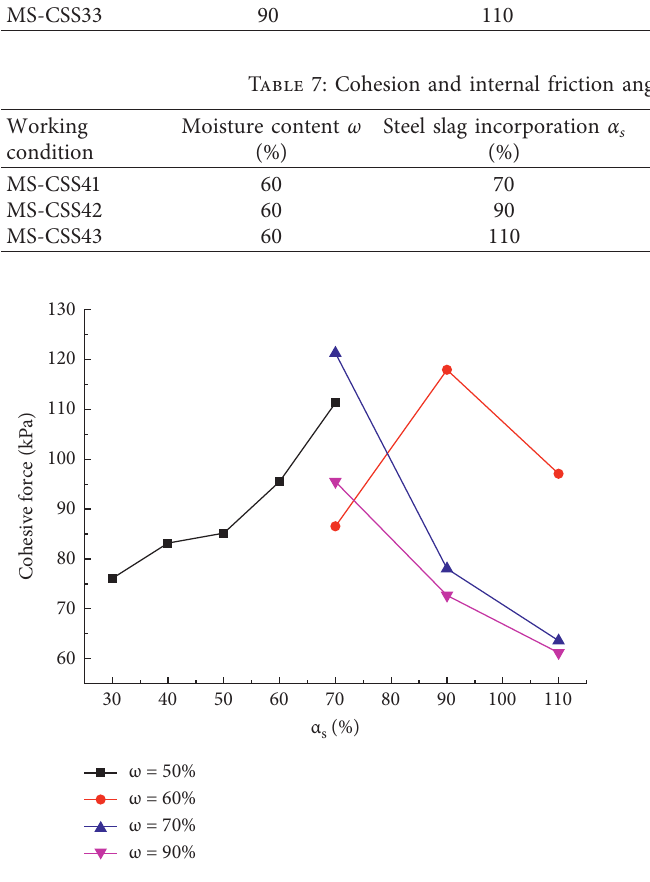
Figure 14: Curve of cohesive force of the mixture.